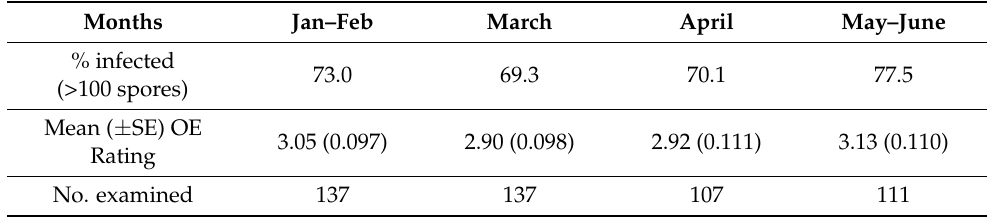
Table 2. Mean monthly OE infection percentage and OE rating of adult monarchs reared from larvae collected in Santa Clara County, CA during January–June 2021. OE Rating key: 1 = zero spores, 2 = <100 spores, 3 = 100–1000 spores, 4 = >1000 spores. No significant difference in ratings between months ( p = 0.472).